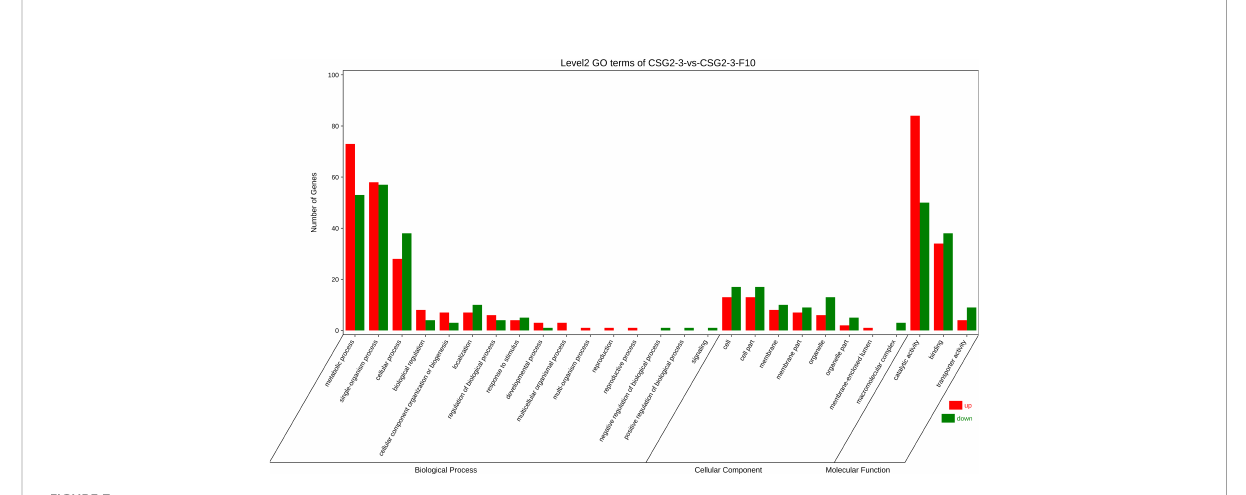
FIGURE 7 Gene Ontology (GO) enrichment analysis of DEGs between CSG2-3 and CSG2-3-F10.